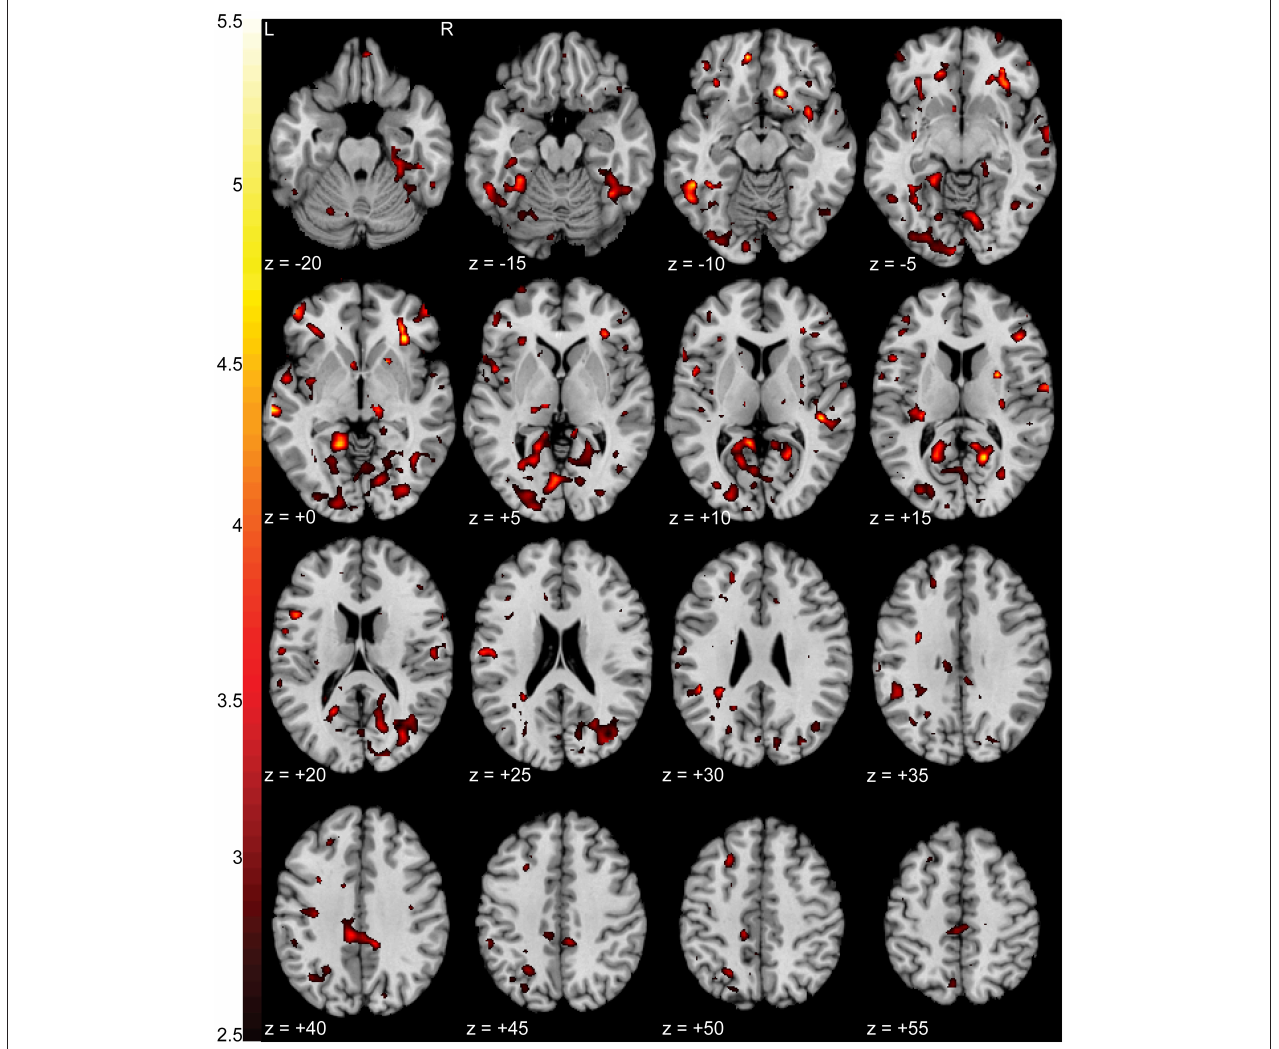
FIGURE 5 | Increased activation in NP subjects during the pain focus state compared to the non-pain focus state. T-statistic mapping of increased BOLD activation ( p < 0.05 uncorrected) during the pain focus state when compared to the non-pain focus state in the NP subject group. Increased activity was seen bilaterally in precuneus, anterior insula, middle temporal gyrus, middle cingulate cortex, and orbitofrontal cortex, and unilaterally in the left lingual gyrus. Clusters fewer than 10 contiguous voxels were filtered for clarity. The difference between axial slices is 5mm and z -values are relative to the AC/PC